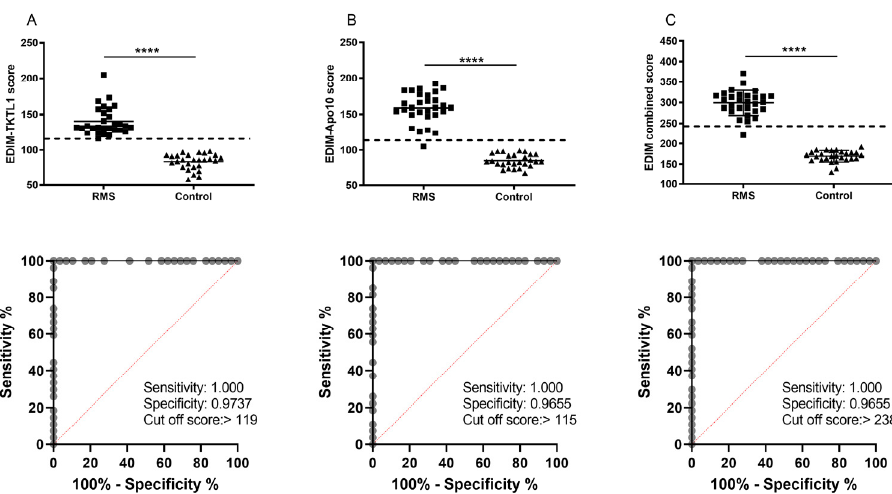
Figure 6. EDIM scores of the patients with rhabdomyosarcoma (RMS) . Receiver operating characteristics (ROC) analysis of TKTL1, Apo10, and combined TKTL1/Apo10 EDIM cut-off score in RMS patients compared with healthy individuals. The true positive rates (sensitivity) are plotted as a function of the false positive rate (1—specificity) for measuring the cut-off point; ROC analysis for the diagnosis of RMS shows calculated cut-off value with highest diagnostic accuracy of TKTL1 (cut-off score > 119; sensitivity 1.000, 95% CI 0.8754–1.000); specificity 0.9737, 95% CI 0.8282–0.9982), Apo10 (cut-off score > 115, sensitivity 1.000, 95% CI 0.8754–1.000; specificity 0.9655, 95% CI 0.8282–0.9982), and combined TKTL1/Apo10 score (cut-off score > 238; sensitivity 1.000, 95% CI 0.8754–1.000; specificity 0.9655, 95% CI 0.8282–0.9982). The dotted line shows the 95% CI. The scatter plots represent ( A ) the EDIM-TKTL1 score (cut-off > 119), ( B ) the EDIM-Apo10 score (cut-off > 115), and ( C ) the combined EDIM-TKTL1/Apo10 score (cut-off > 238). The dotted lines indicate the cut-off values of the scores. **** p < 0.0001indicates statistical significance (Students T-Test).